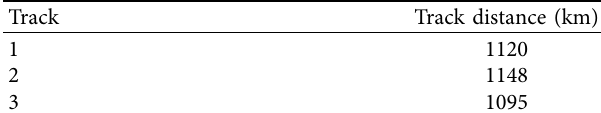
Figure 12: Path 3 covered by volcanic ash. Table 5: Three trajectory distances from Algiers to